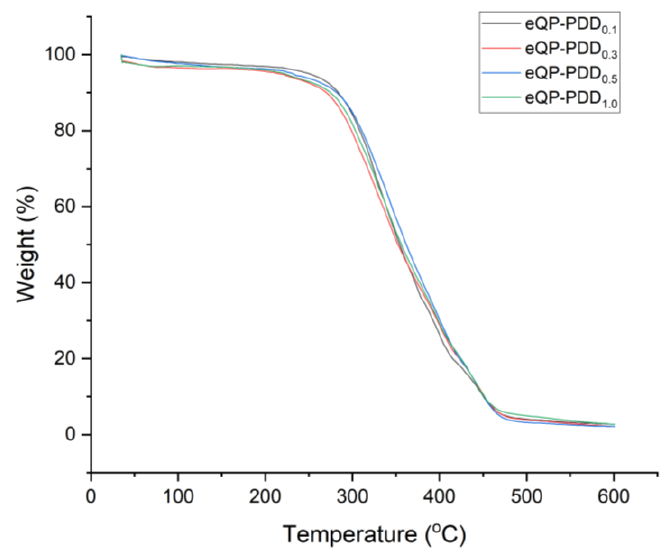
Figure 7. Thermogravigrams of eQP-PDD x AEMs.